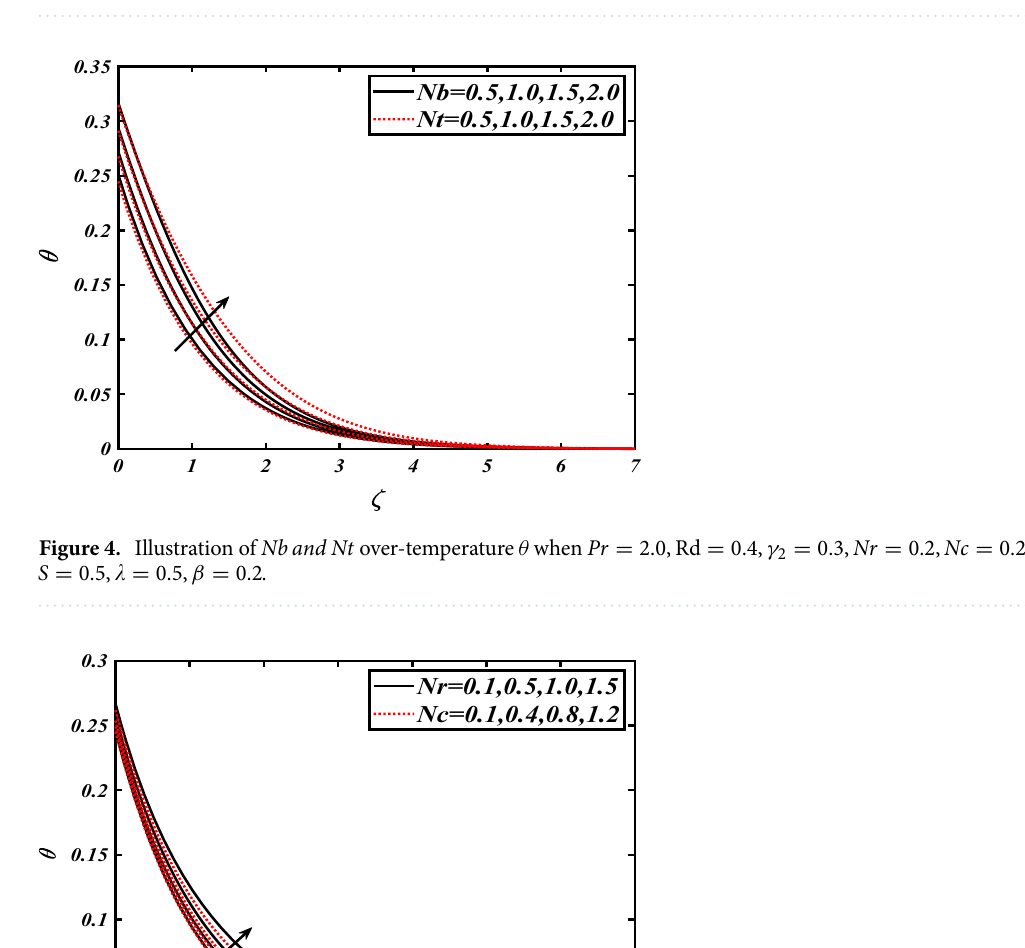
Figure 3. Illustration of α and γ 1 over-temperature θ when Pr = 2.0, Rd = 0.4, γ 2 = 0.3, Nb = 0.2, Nt = 0.3, S = 0.5, (cid:31) = 0.5, β = 0.2 .